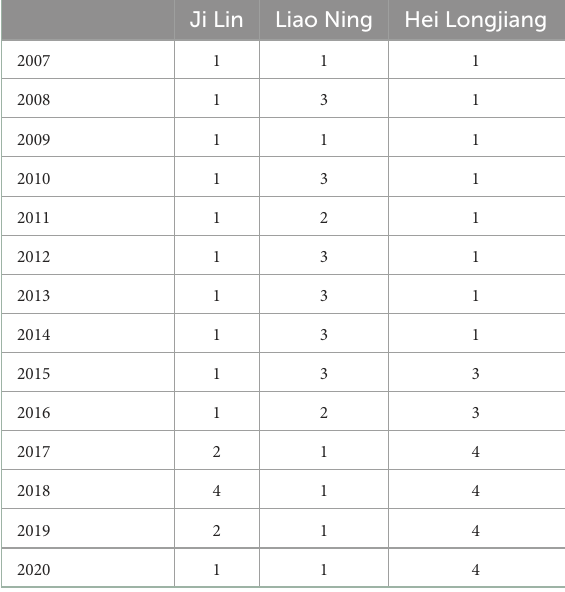
TABLE 5 Evaluation grade of sustainable development of APSC in the three northeast provinces. Ji Lin Liao Ning Hei